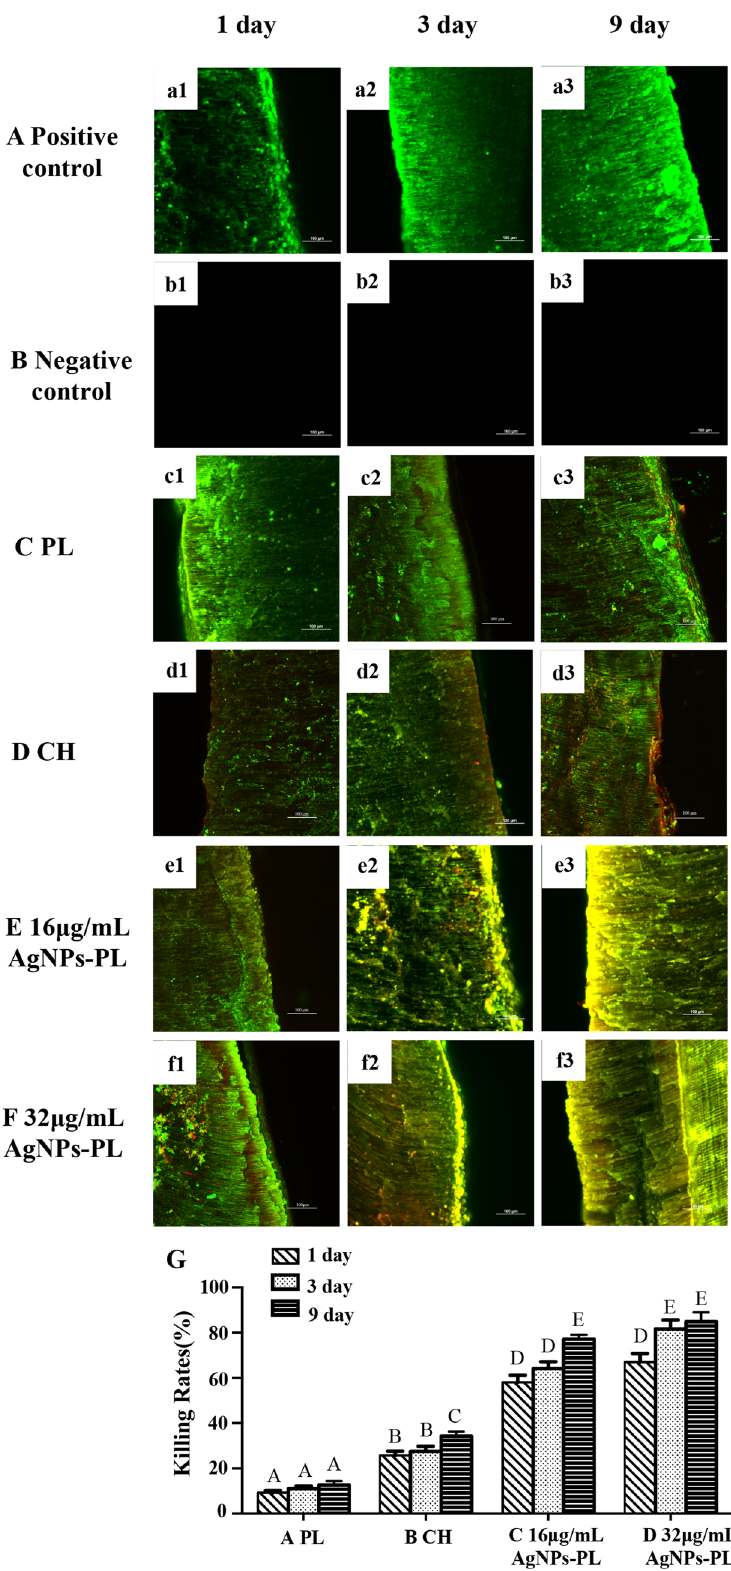
Figure 8. Representative live/dead bacterial staining images of the split dentin infected with E. faecalis and then treated with different drugs: ( a1 – a3 ) PL group; ( b1 – b3 ) CH group; ( c1 – c3 ) 16 μg/mL AgNPs-PL group; ( d1 – d3 ) 32 μg/mL AgNPs-PL (scale bar: 100 μm); ( e ) Comparison of killing rates of different agents. Live bacteria were stained green, and dead bacteria were stained red. Significant differences between columns are labeled by different upper-case letters ( p <